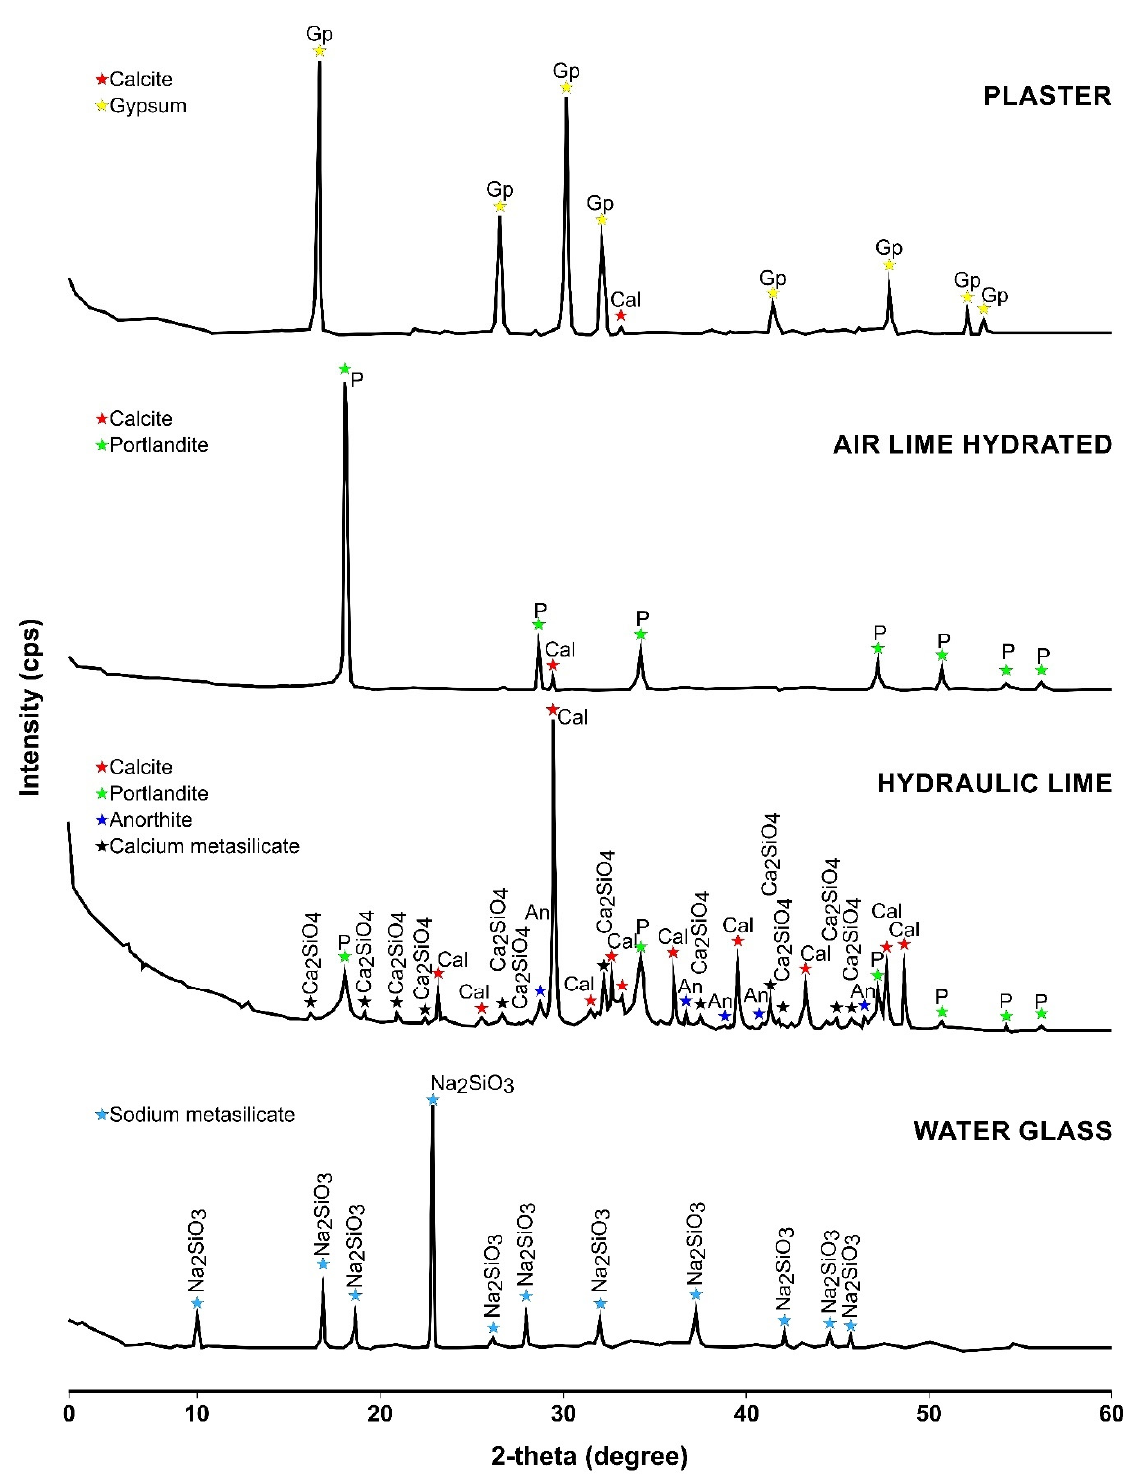
Figure 1. X-ray diffractograms for the plaster, hydrated air lime, hydraulic lime and water glass [60]. Abbreviations for names of rock-forming minerals.